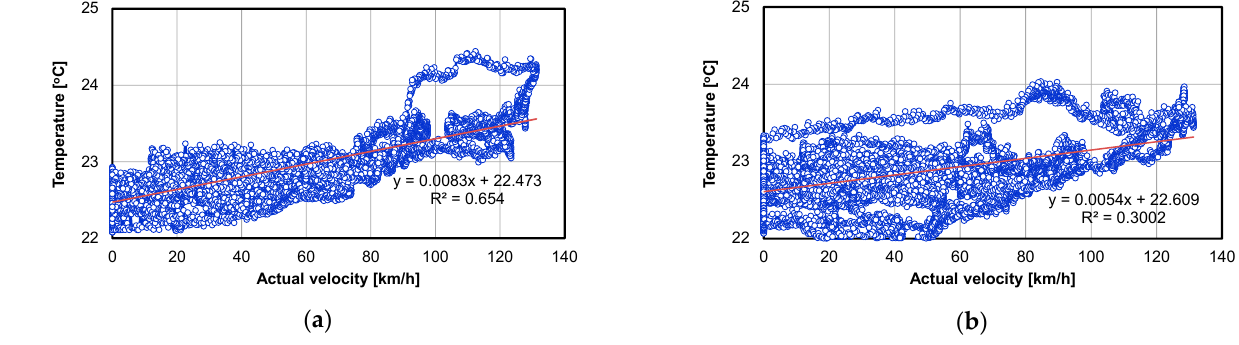
Figure 5. Temperature of dry air versus actual velocity for: ( a ) plug-in; ( b ) HEV. Figure 6b for HEV. For the low velocity phase of the WLTC test, the absolute humidity in the case of the plug-in was lower by up to 0.5 g/kg compared to that in the case of HEV. It also resulted from the conditions in the place where the dyno was located. The relation between absolute humidity and actual velocity are shown in Figure 7a for the plug-in and as the increase in the actual velocity than in the case of the plug-in. The dispersion of values of the absolute humidity decreased with the increase in actual velocity in both cases.